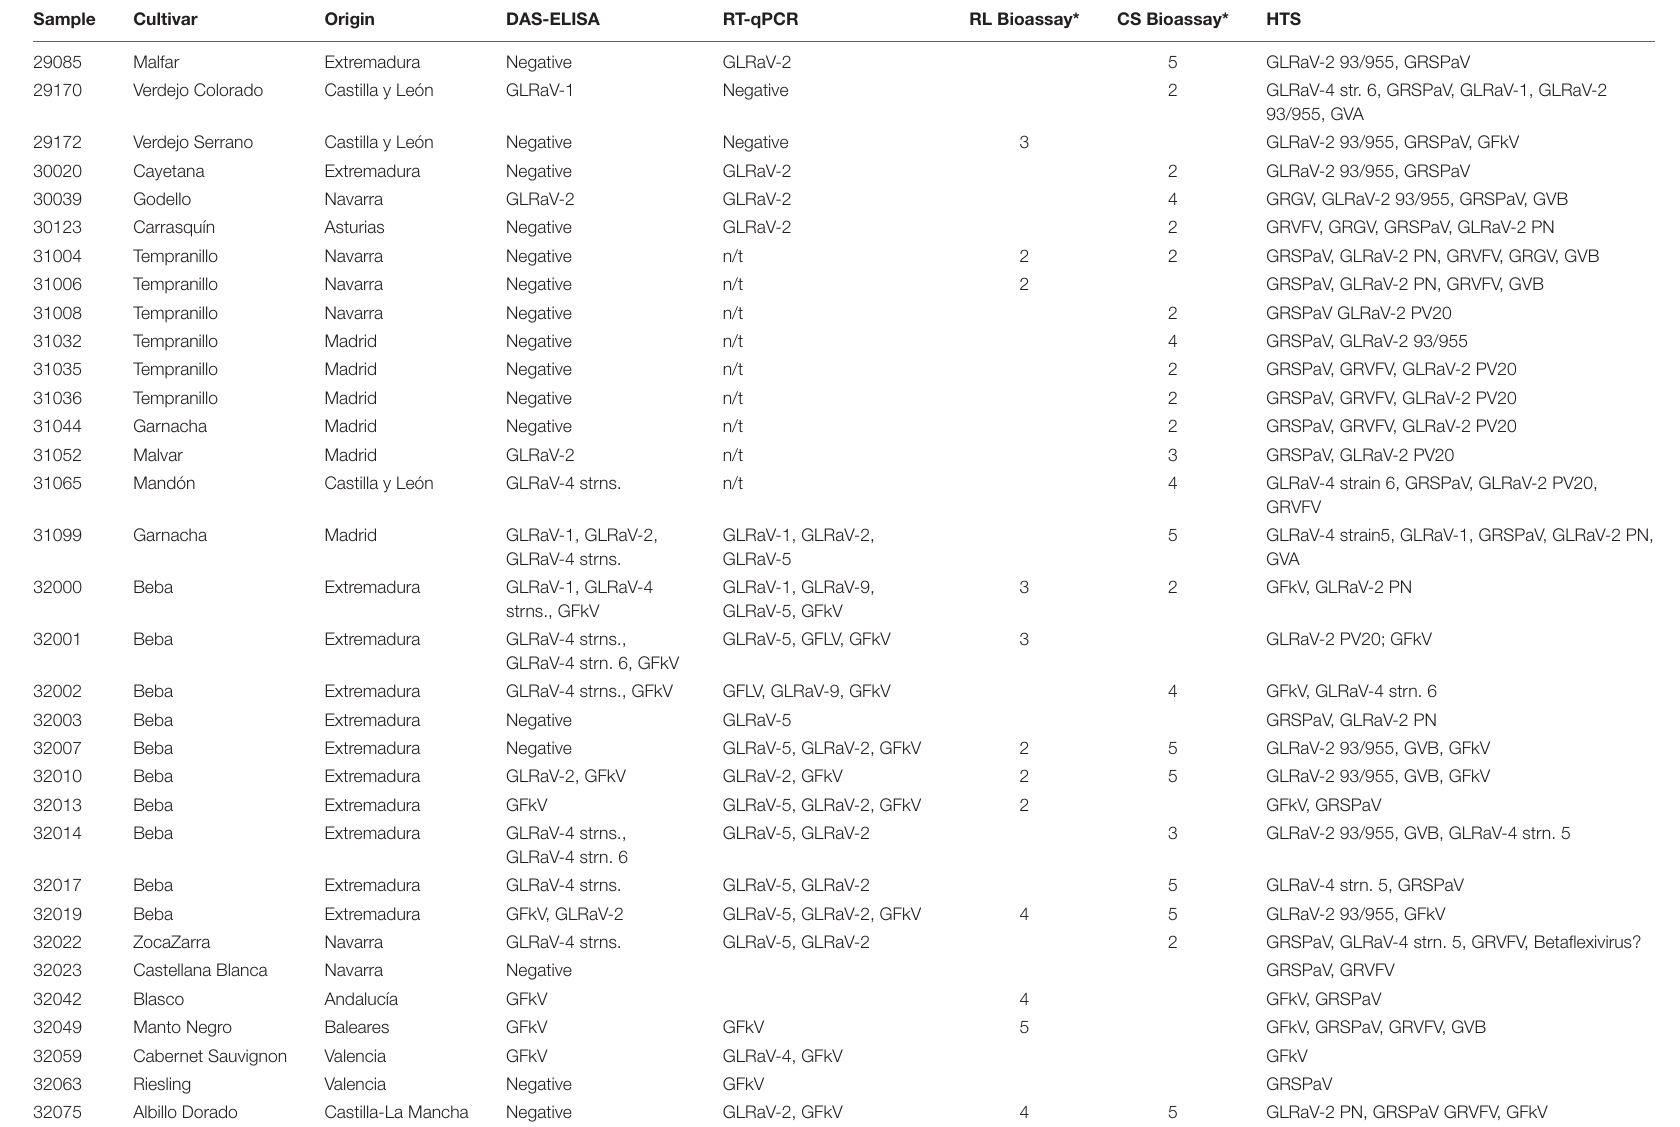
TABLE 3 | Comparison among the four diagnostics methods used in this study for the diagnostics of viruses in the grapevine samples.